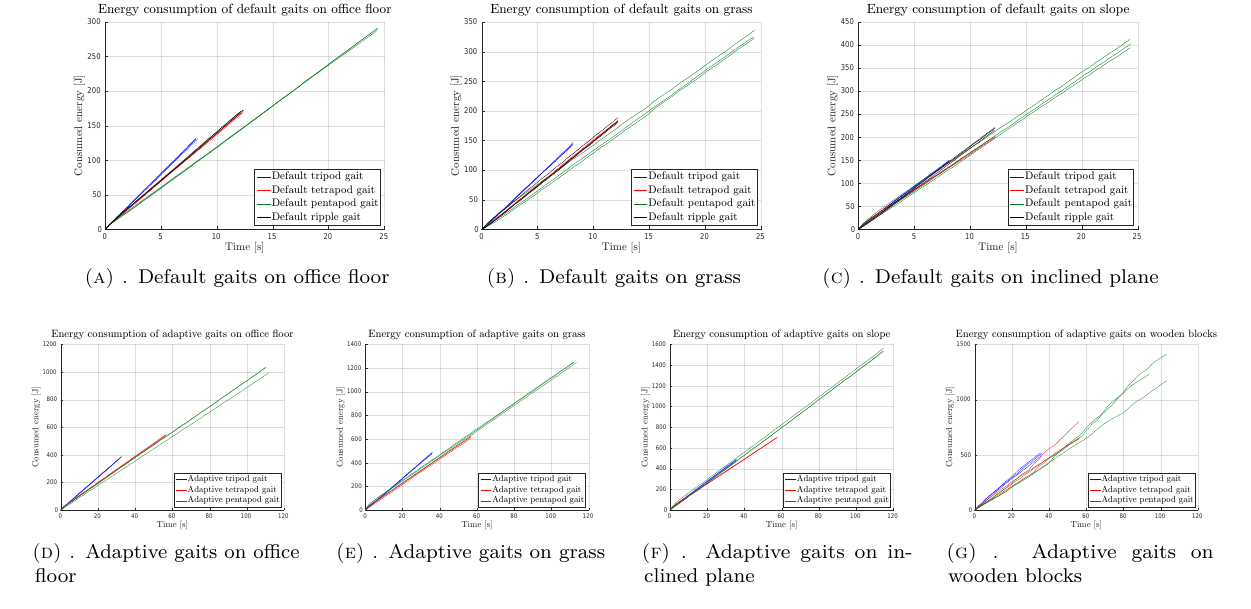
Figure 2. Energy consumption over